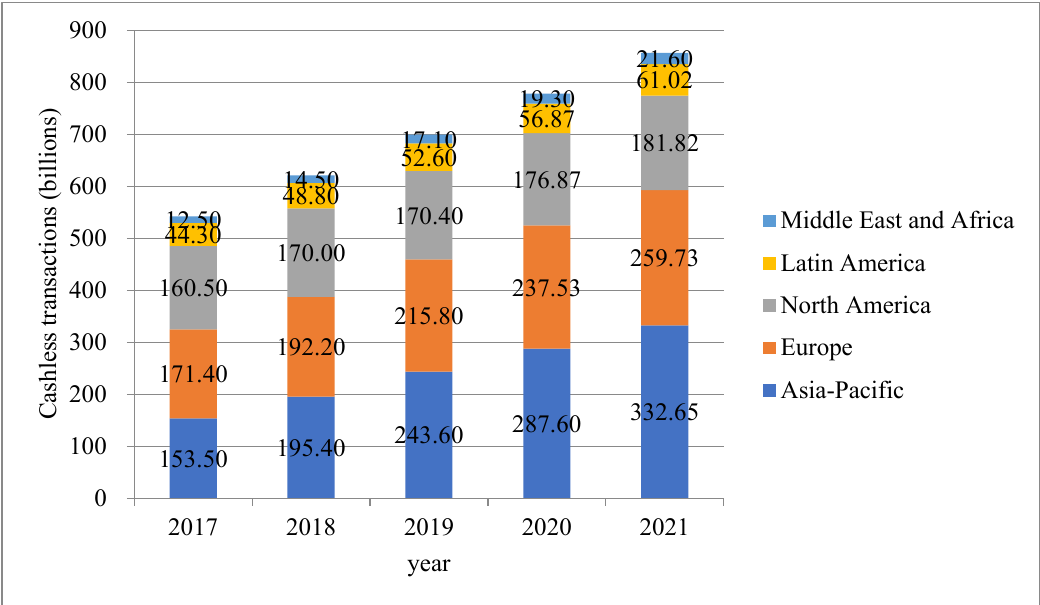
Figure 1. The increasing trend of cashless transactions. Notes: The data in this figure comes from World Payments Report 2020. The data in 2021 is forecasted.